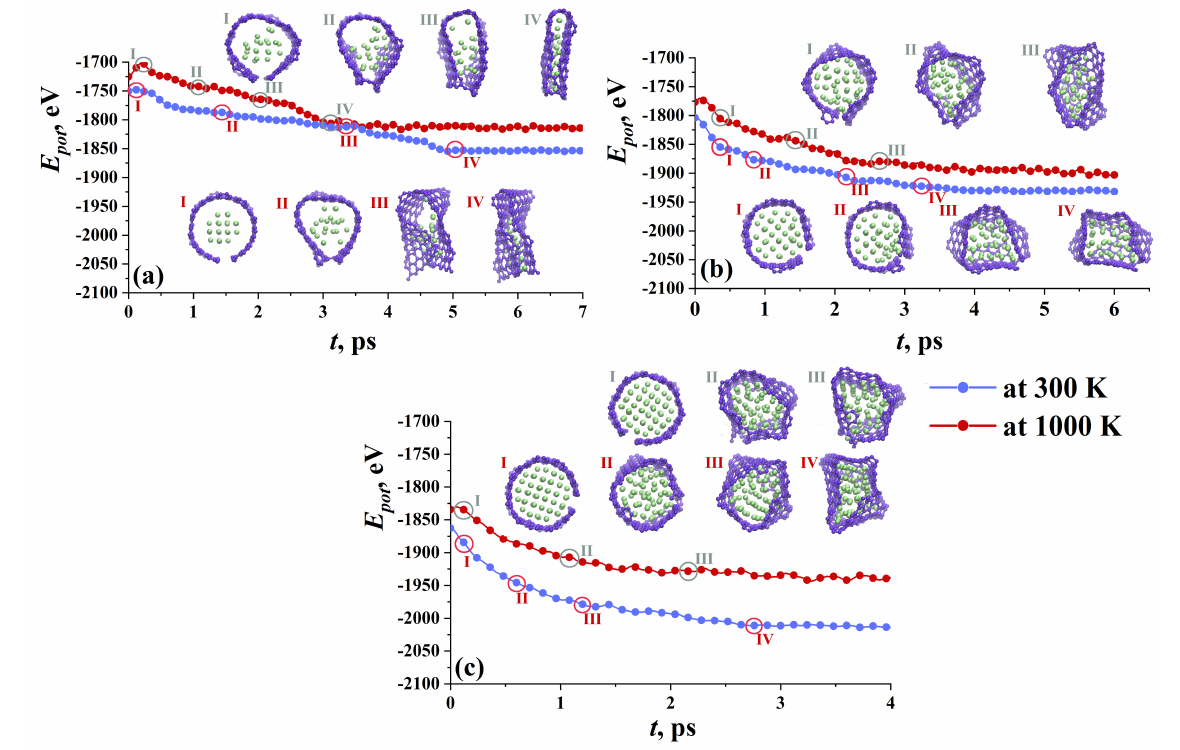
Figure 3. Potential energy as the function of exposure time for Ni 21 ( a ), Ni 47 ( b ) and Ni 66 ( c ). Corresponding snapshots of the structure of crumpled graphene flake filled with nanocluster during exposure at 300 K (bottom line of snapshots) and 1000 K (upper line of snapshots). Carbon atoms are shown by violet and nickel atoms are shown by